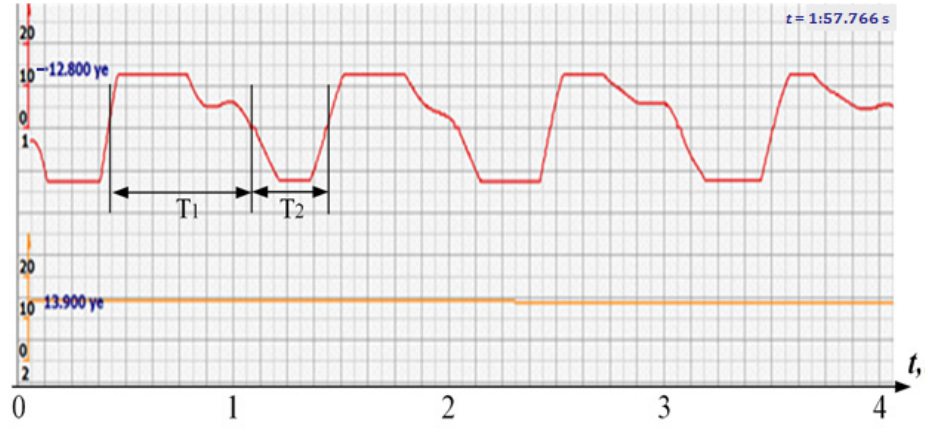
Figure 8. Measurement of the time intervals of the converted signal by its zero values—T 1 —”positive” half-wave and T 2 —”negative ” .